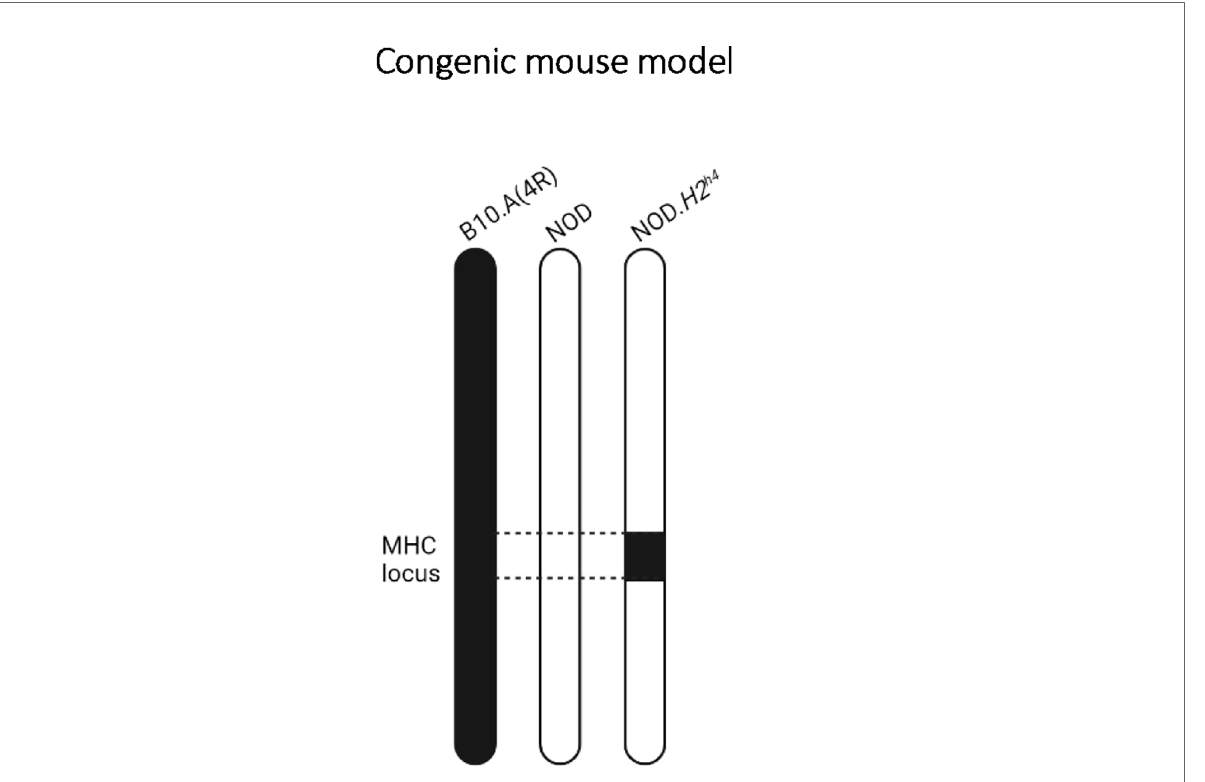
FIGURE 1 | The NOD. H2 h4 congenic mouse model. Representation of the mouse chromosome 17 from the parental B10.A(4R) (left), parental NOD (middle), and congenic NOD. H2 h4 (right) strains. By backcrossing NOD mice to B10.A(4R), the thyroiditis-prone H2 h4 MHC locus from chromosome 17 of the parental B10.A(4R) mouse has been selected at each backcross generation to replace in the NOD-derived H2 g7 MHC locus, resulting in the NOD. H2 h4 congenic